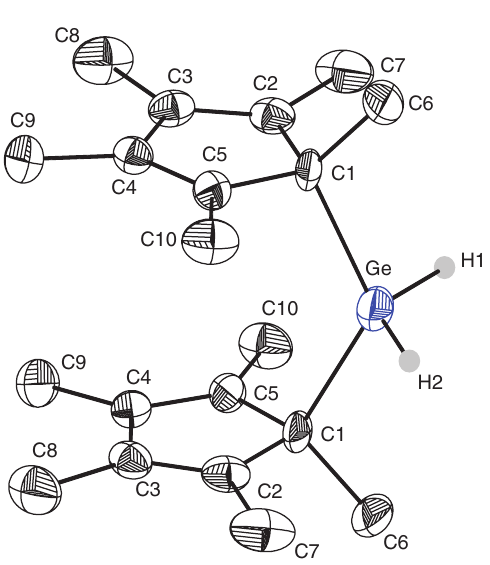
Figure 1: ORTEP at 40% probability for the carbon and germanium atoms and atom numbering scheme for compound 1 . Hydrogen atoms of the methyl groups are omitted for clarity. Hydro- gen atoms at the germanium are given in ball and stick type.